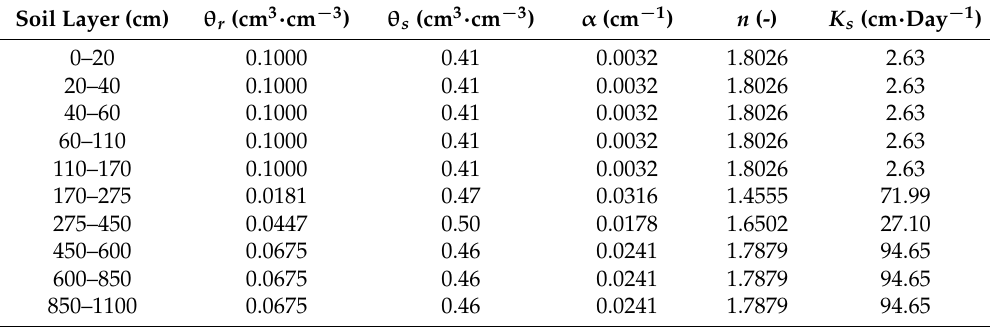
Table 2. Soil moisture parameters of the van Genuchten–Mualem model for different soil horizons at the experimental site.